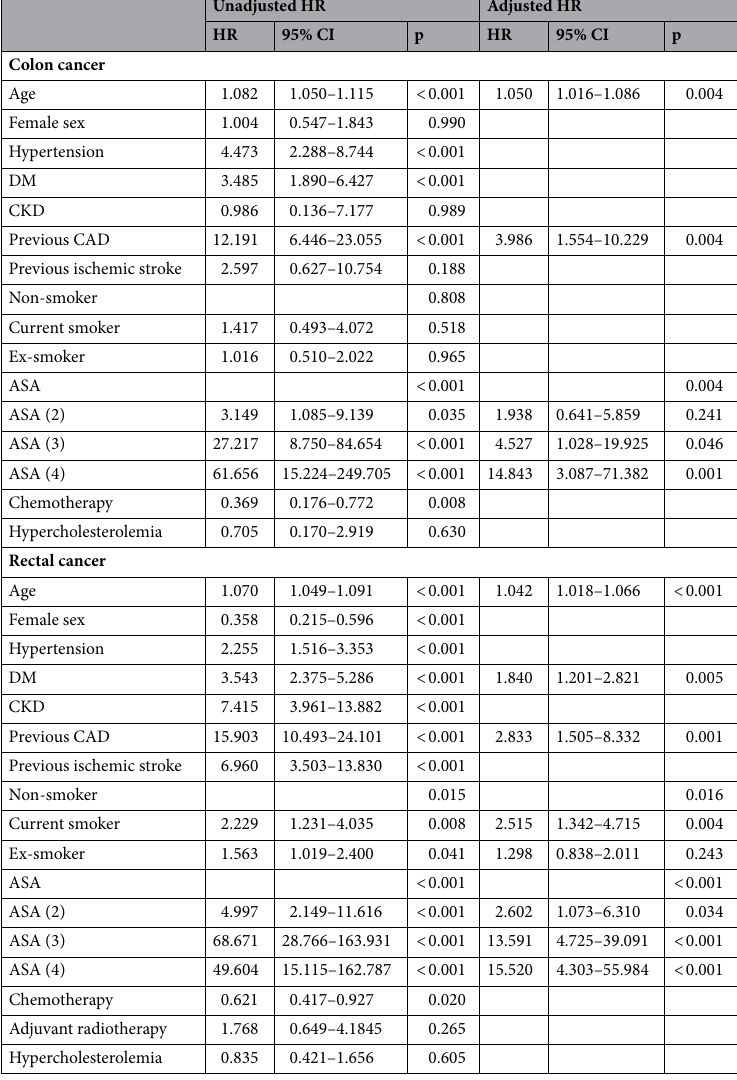
Table 4. Subgroup analysis of the independent predictors of new-onset cardiovascular diseases in patients with colon and rectal cancer. ASA American Society of Anesthesiologists Physical Status Classification System, BMI body mass index, CAD coronary arterial disease, CI confidence interval, CKD chronic kidney disease, DM diabetes mellitus, HR hazard ratio.